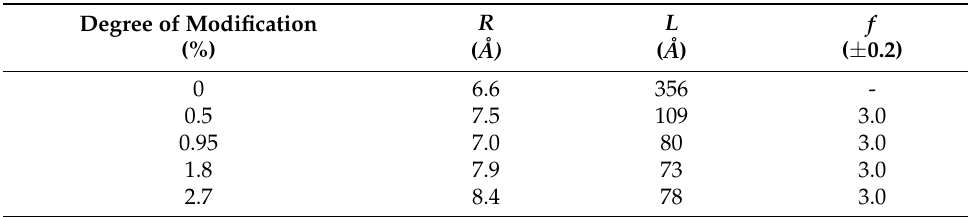
Table 1. Fitted structural parameters of the family of cat-HEC polymers. R is radius, L is length, and f is fractal